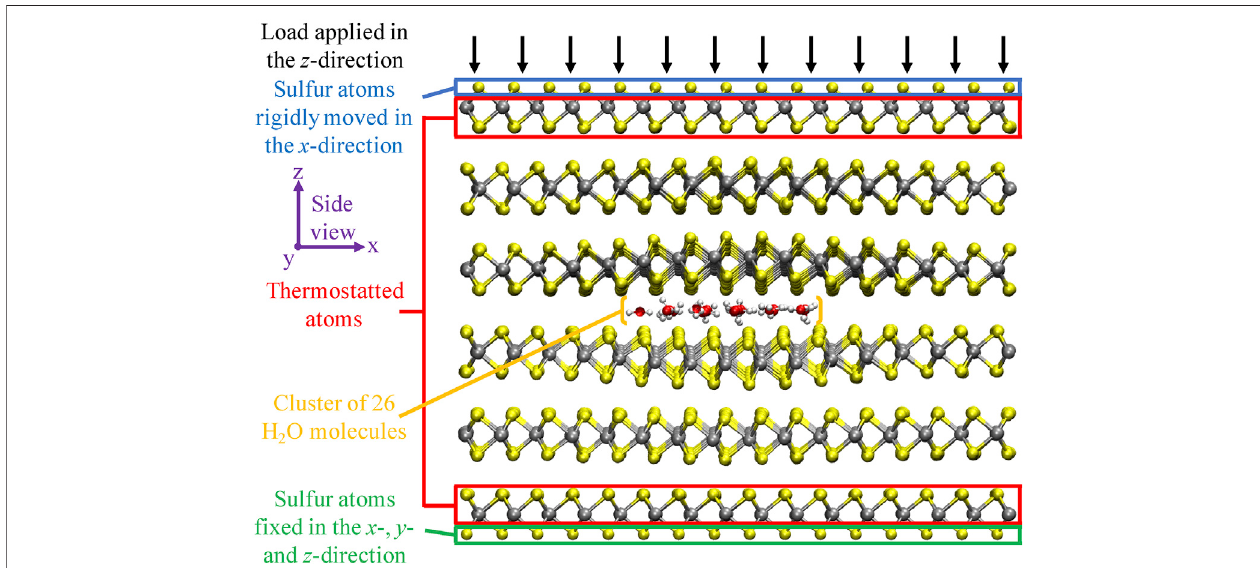
FIGURE2| Schematicoverviewofthecomputationalsetup.The sideviewofthesix-layered MoS 2 structure,withaclusterof26H 2 Omoleculesintercalated inthe centerinterface,isdisplayed.Molybdenum,sulfur,oxygen,andhydrogen atomsaredisplayedinsilver,yellow,red,andwhite,respectively.Thisspeci fi ccaseresembles the system after equilibration at 0 GPa load and 300 K. From this picture, there is a clear structural deformation visible in the MoS 2 layers directly encapsulating the H 2 O cluster. Figure was obtained with VMD (Humphrey et al., 1996).